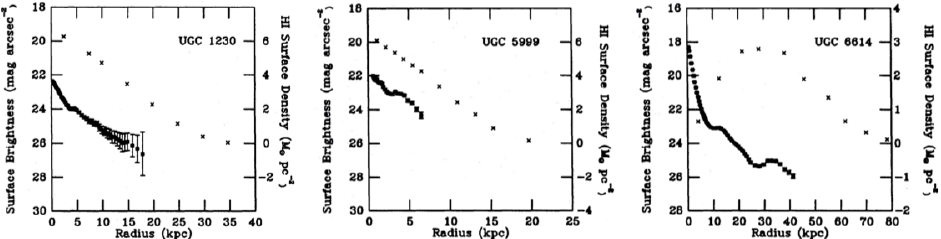
Figure 6. The radial distribution of the R-band surface brightness and the HI surface density in three LSBs. The image is reproduced from [34] (Figure